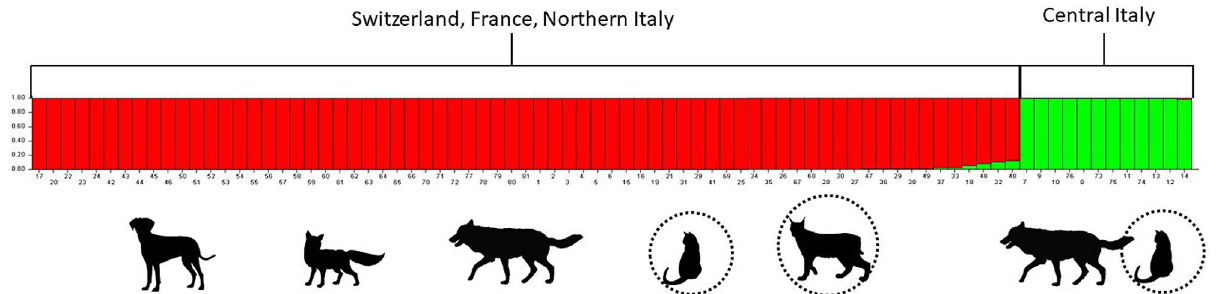
Figure 1. Barplot of Sarcoptes -derived genetic clusters generated with the software Structure 2.3.4 with maximum likelihood K = 2. Each mite is represented by a single bar, and the height of each coloured segment is proportional to the membership fraction in each cluster. Felids are marked with a dotted circle.